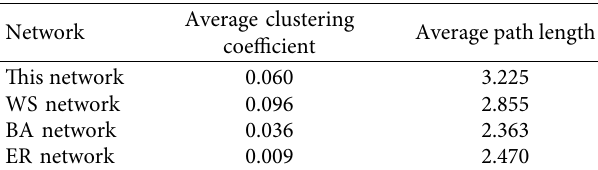
Table 3: Average clustering coefficient and average shortest path of different networks.